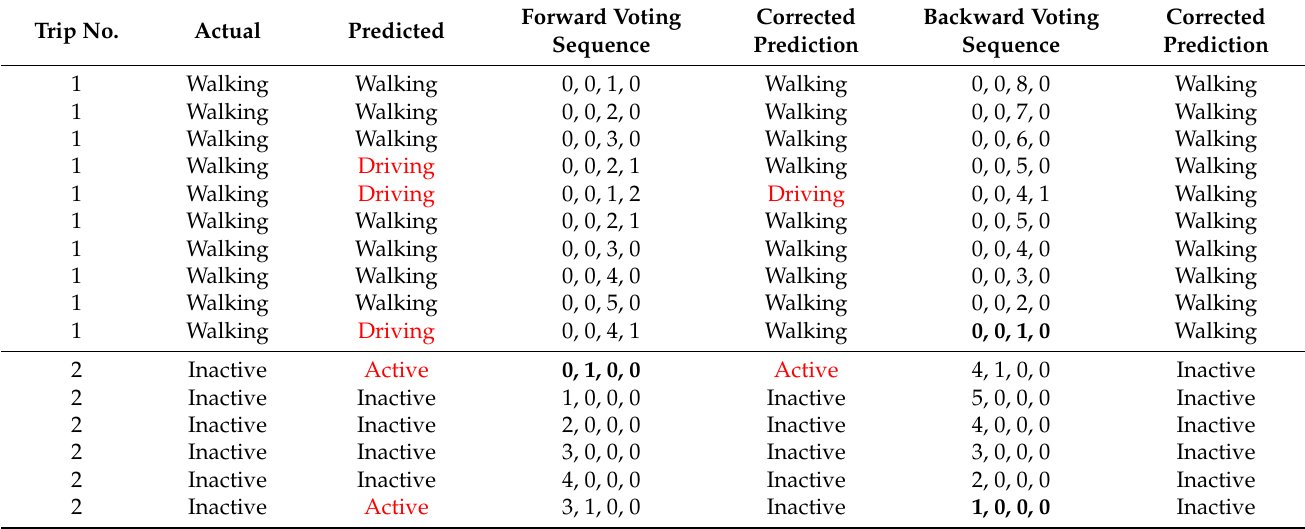
Table 4. Example of a forward and backward voting